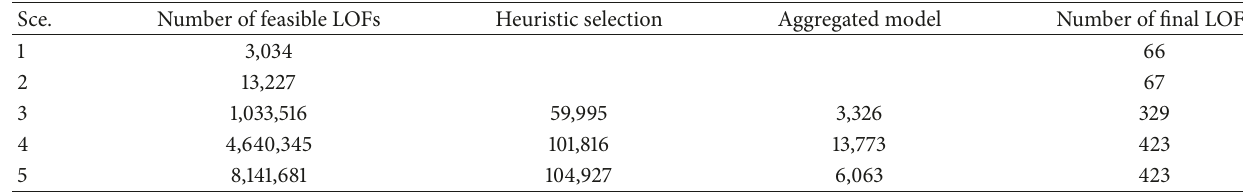
Table 4: Results of the LOF selection after each stage.